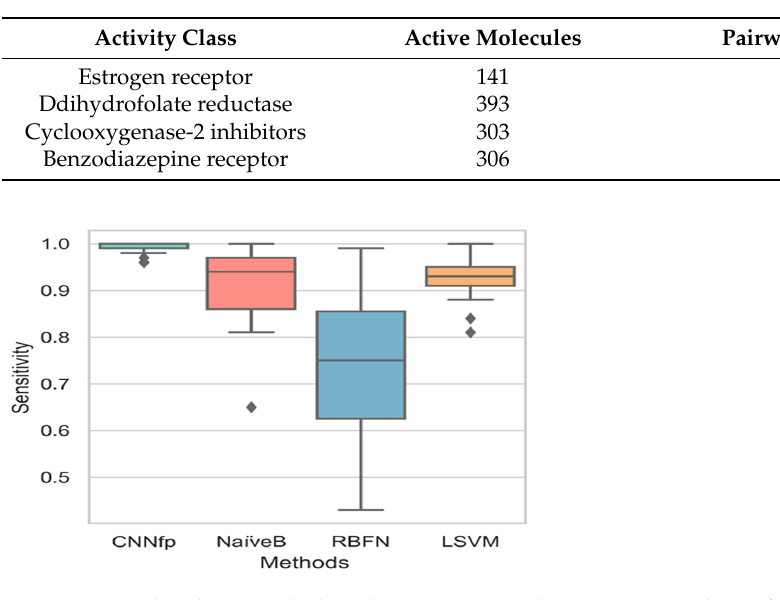
Table 7. Sutherland activity classes.